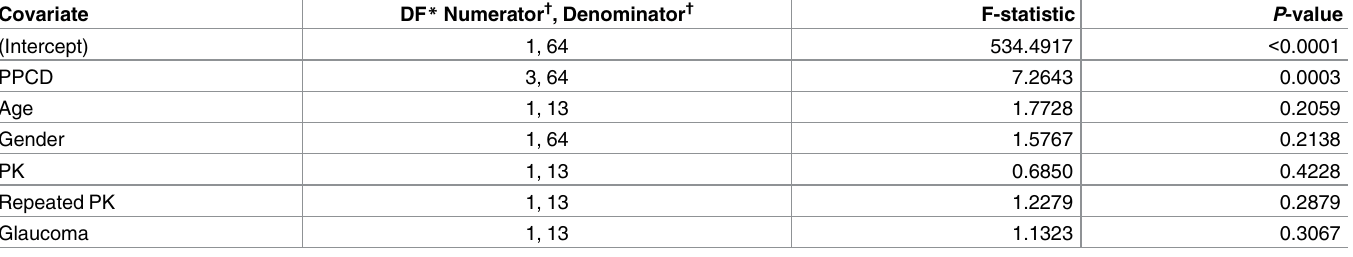
Table 3. Influence of different independent factors on the levels of active TGF- β 2 analyzed by analysis of variancebased on the fully adjusted model.